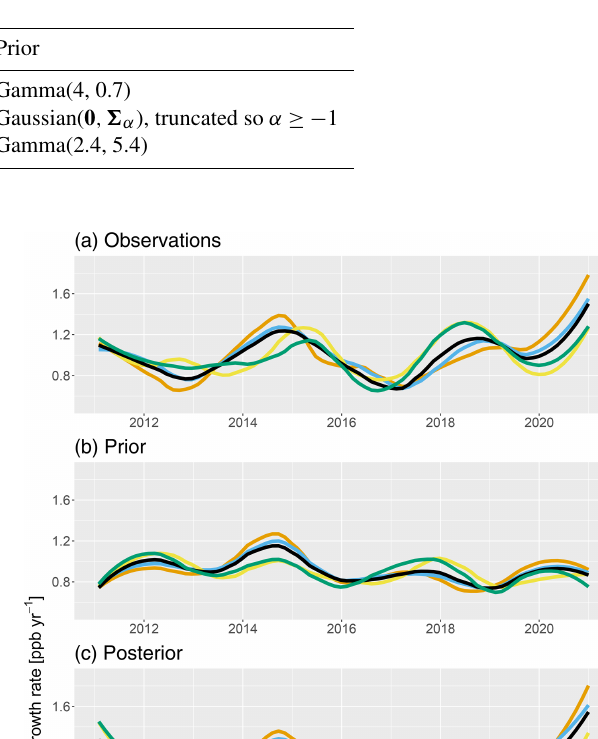
Table 3. Parameters optimized in the inversion, along with their prior distributions. The values used in the measurement-error variance inflation factors’ prior are given to 1 decimal place.